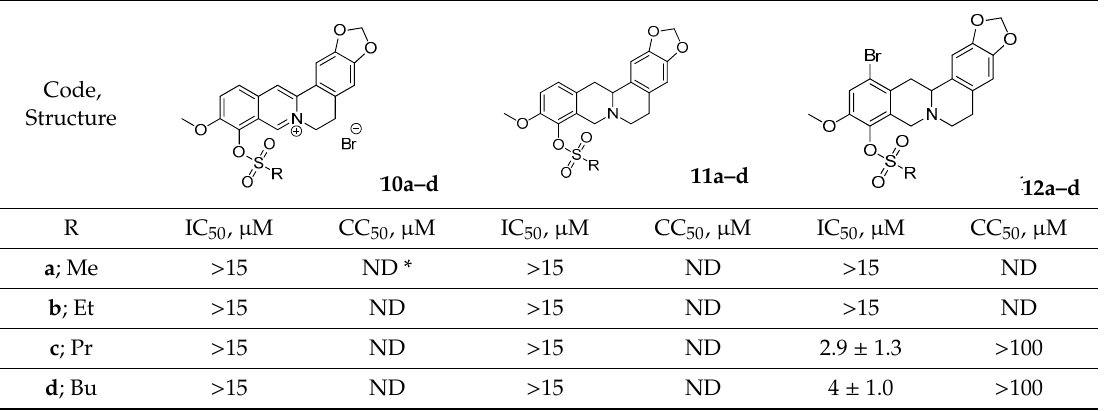
Table 1. Tdp1 inhibiting activity (IC 50 —half maximal inhibitory concentration) of sulfonate berberine derivatives with aliphatic substituents and their cytotoxicity (CC 50 —half maximal cytotoxic